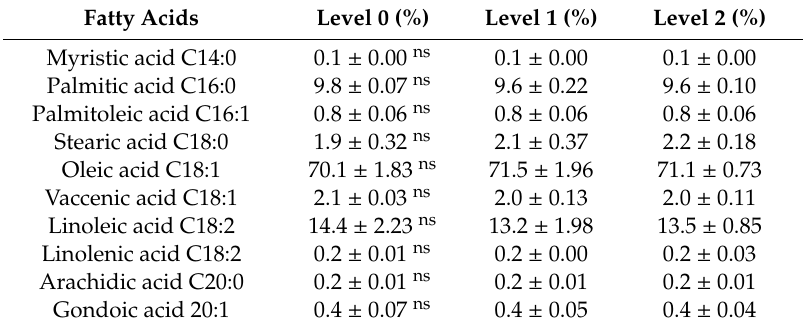
Table 4. Fatty acid composition (percentage in oil, %) of kernels a ff ected by di ff erent levels of water